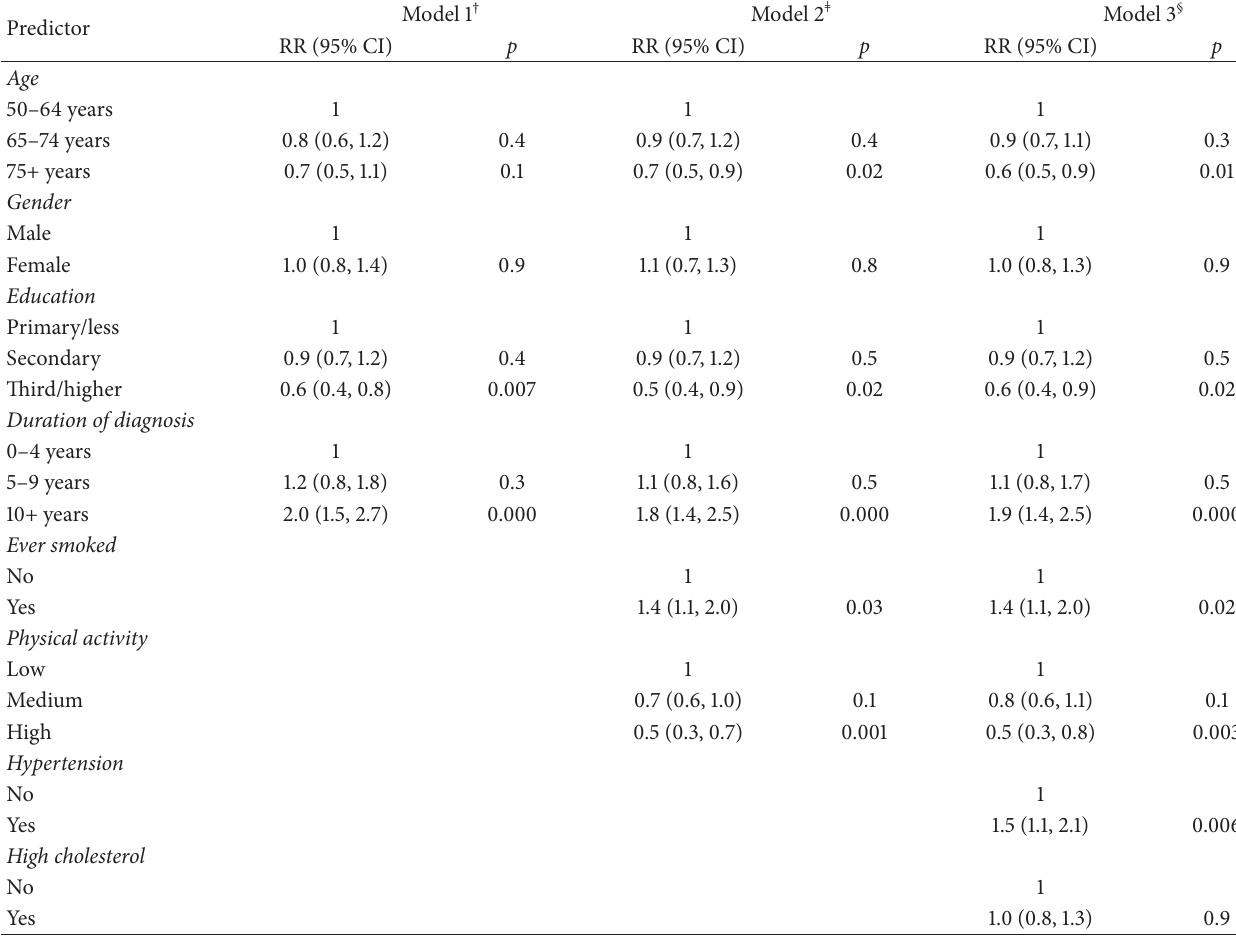
Table 3: Multivariate binomial regression models exploring independent associations between microvascular complications and predictor variables ∗